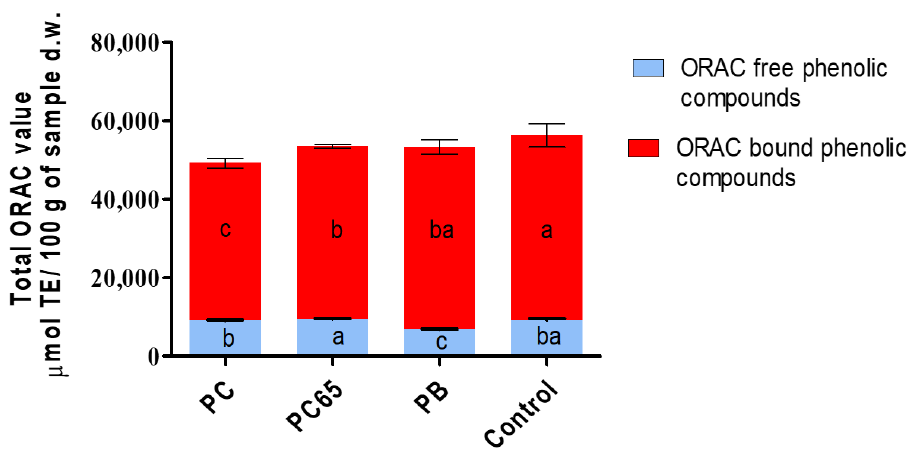
Figure 5. ORAC values for the contents of total, free, and bound phenolic compounds present in the energy snacks. Different letters present in the same column color are statistically different ( p < 0.05).